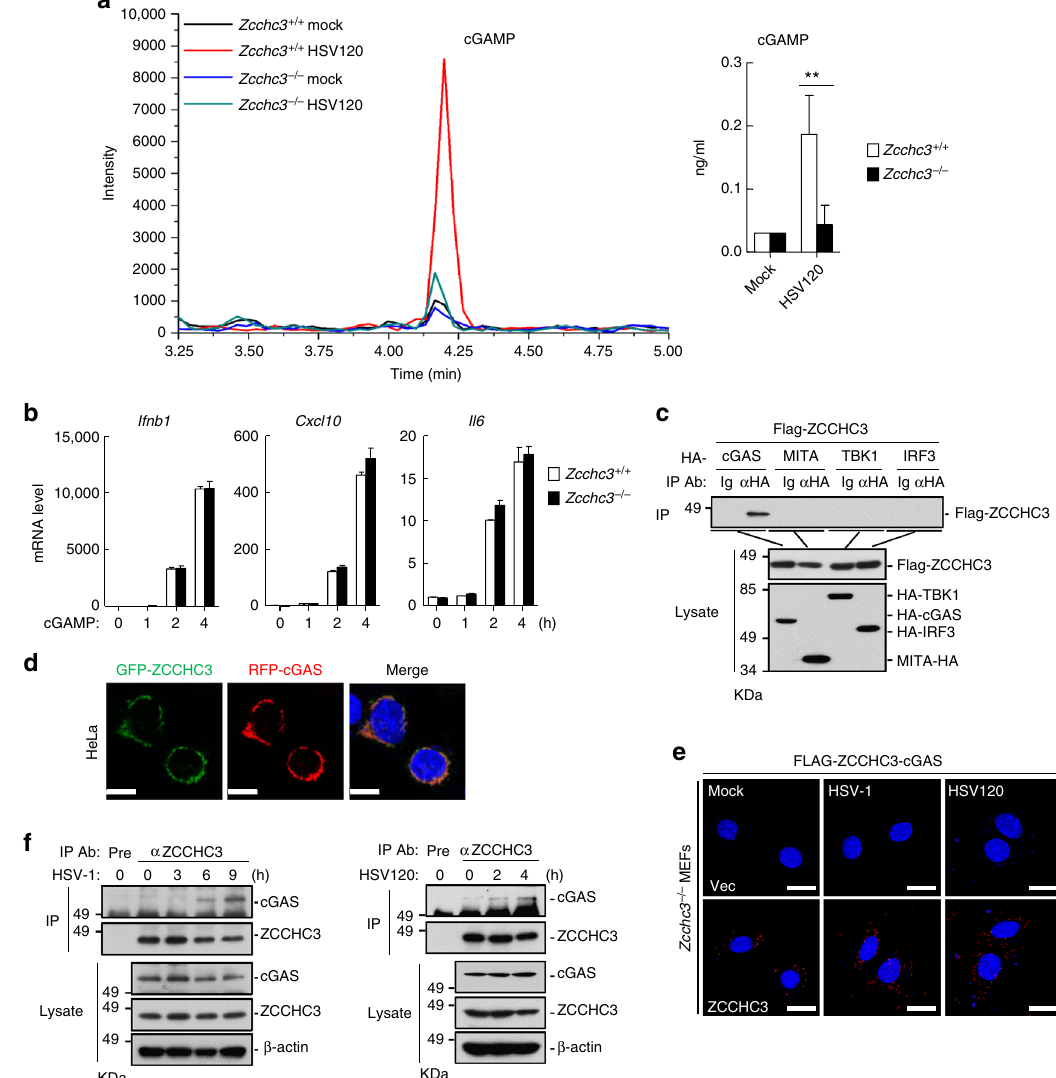
Fig. 4 ZCCHC3 acts at the level of cGAS. a Effects of ZCCHC3-de fi ciency on cGAMP synthesis induced by transfected HSV120. Zcchc3 + / + and Zcchc3 − / − MLFs were left untreated or treated with HSV120 (3 μ g/ml) for 4 h, and then cell extracts containing cGAMP were separated by chromatography using a C18 column, the abundance of cGAMP was quantitated by mass spectrometry using SRM. The concentration of cGAMP (ng/ml) in Zcchc3 + / + and Zcchc3 − / − MLFs was shown in the right histograph (mean ± SD, n = 3 technical repeats, **P < 0.01. b Effects of ZCCHC3-de fi ciency on transcription of downstream genes induced by cGAMP. Zcchc3 + / + and Zcchc3 − / − MLFs were left un-treated or treated with 2 ′ 3 ′ -cGAMP (0.2 mg/ml) for 4 h before qPCR analysis. c ZCCHC3 is associated with cGAS. HEK293 cells were transfected with the indicated plasmids before co-immunoprecipitation and immunoblotting analysis. d Colocalization of ZCCHC3 with cGAS. HeLa cells were transfected with GFP-ZCCHC3 and RFP-cGAS for 20 h before confocal microscopy. Scale bars, 10 μ m. e PLA analysis of ZCCHC3 and cGAS interaction. Zcchc3 − / − MEFs reconstituted with an empty vector or Flag-ZCCHC3 were infected with HSV-1 or transfected with HSV120 (3 μ g/ml) for 4 h before PLA analysis. Scale bars, 20 μ m. f Endogenous ZCCHC3 is associated with cGAS in THP1 cells. THP1 cells were left un-infected or infected with HSV-1or transfected with HSV120 (3 μ g/ml) for the indicated times before co-immunoprecipitation and immunoblotting analysis. Data are representative of at least two experiments with similar